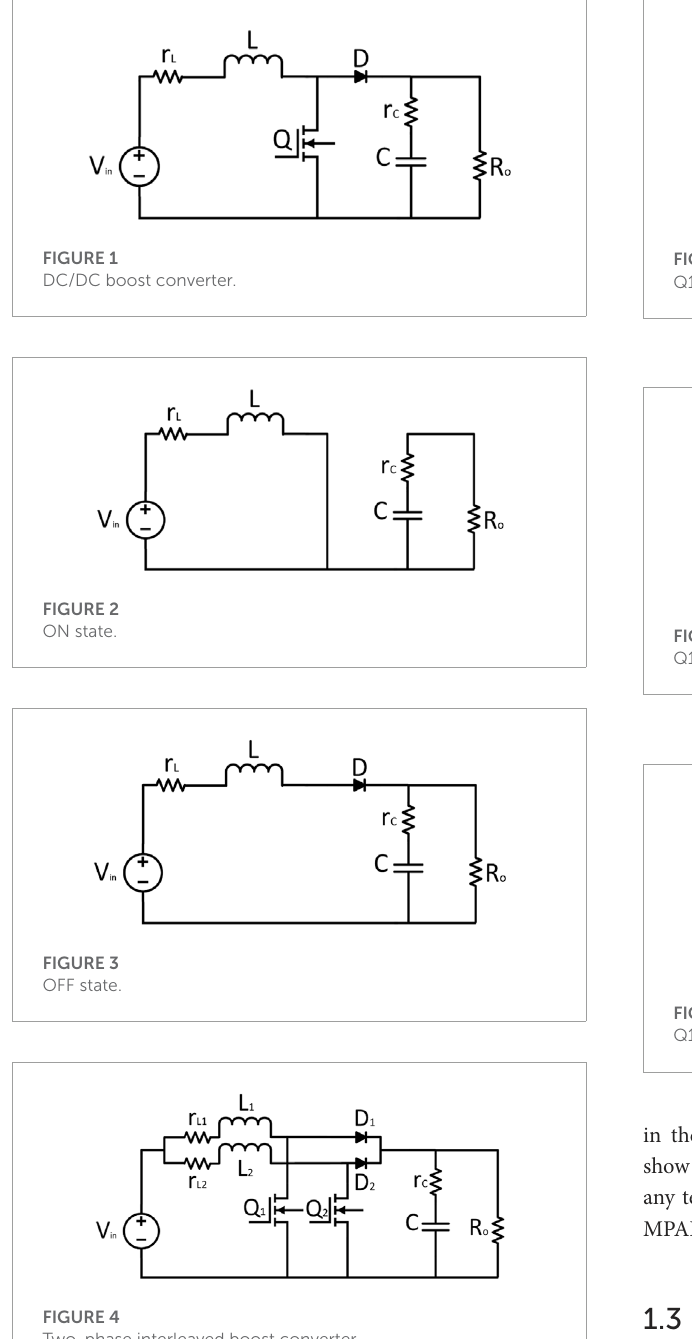
FIGURE 4 Two-phase interleaved boost converter.